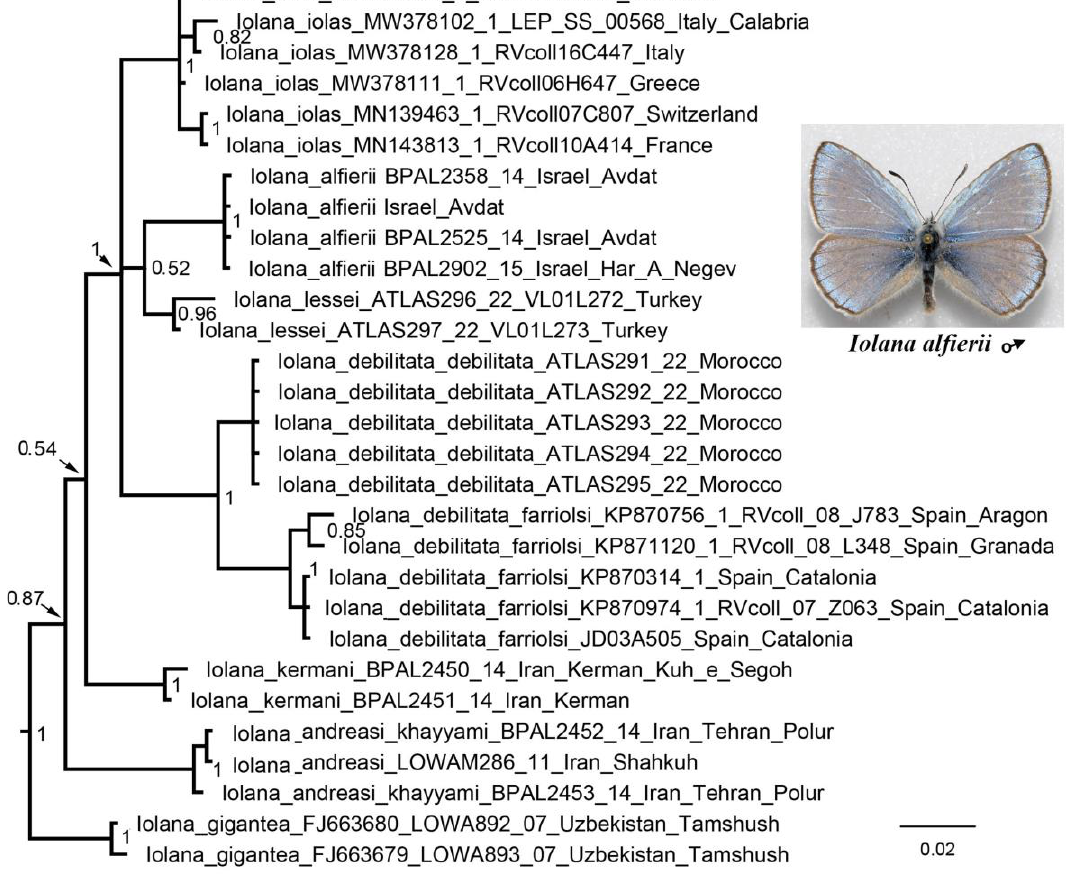
Figure 6. Fragment of the concatenated ( 28S + H3 + EF1-a + wingless + ITS2 + COI + COII ) BI tree. The genus Iolana is shown. Posterior probabilities are indicated at the nodes.